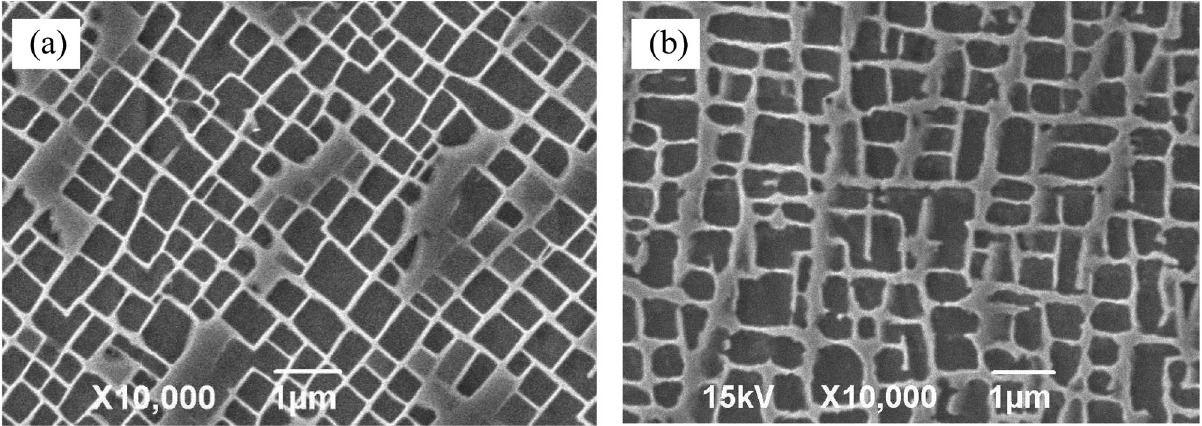
Figure 12: Microstructures of the specimens: ( a ) original specimen and ( b ) after the HCF test.